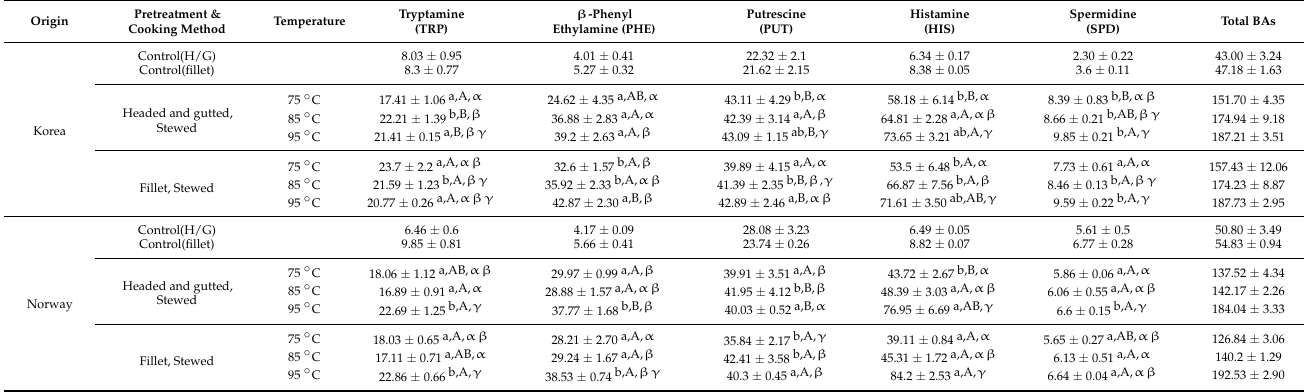
Table 5. Concentrations of BAs in stewed mackerel